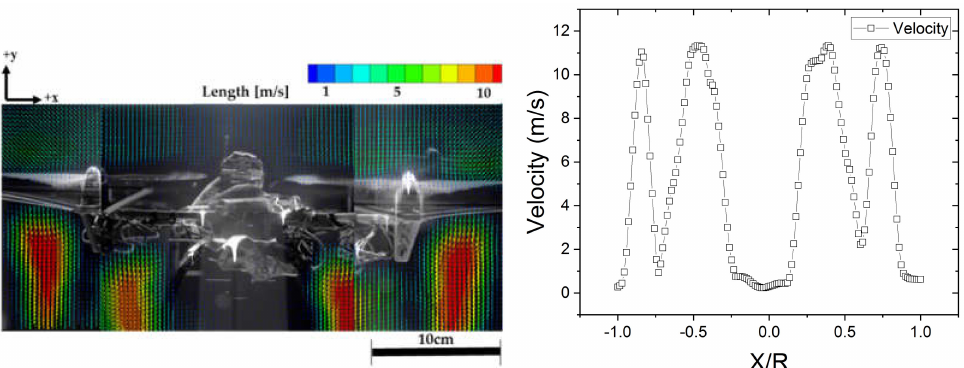
Figure 5. Vertical distribution of the velocity field around the drone: ( Left ) visualization and ( Right ) magnitude with respect to rotor spacing.